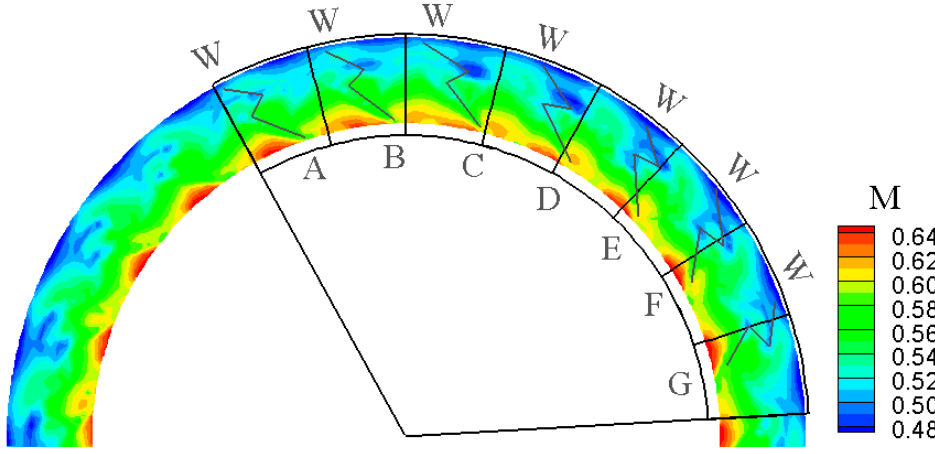
Figure 11. Snapshot of M distribution over multiple channels in different stator–rotor positions.